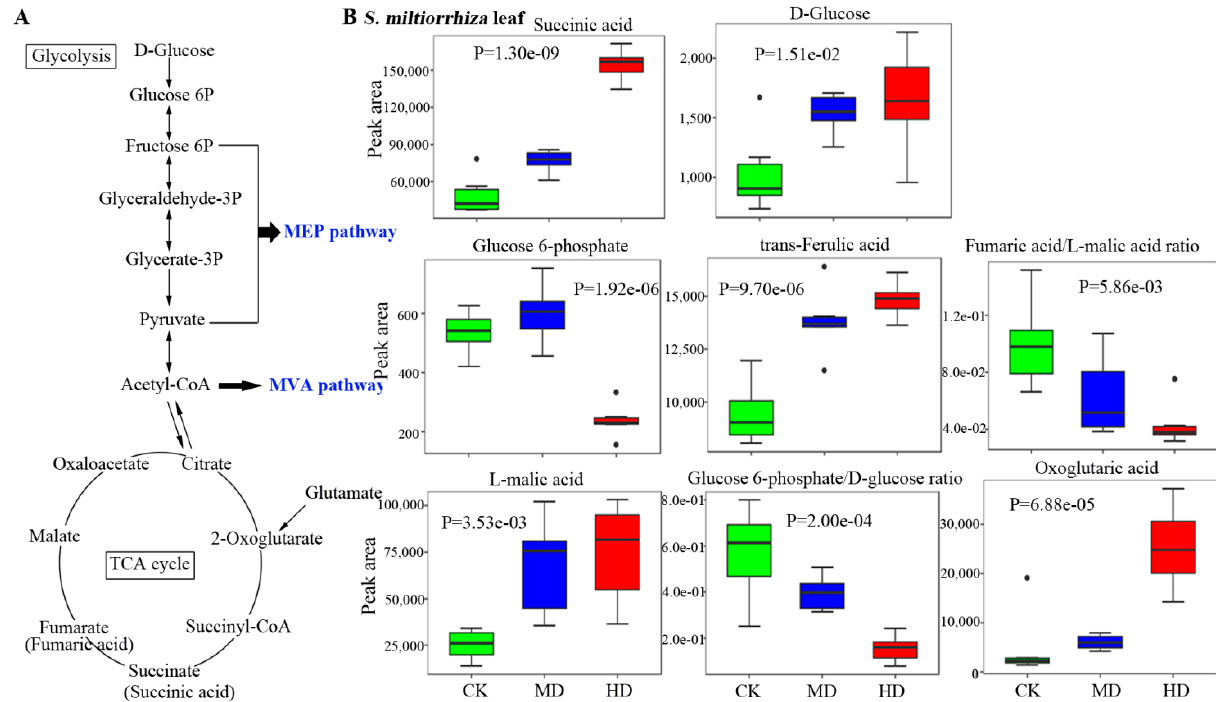
Figure 4. Metabolic profiles of terpenoid biosynthesis metabolites in Salvia miltiorrhiza Bunge. ( A ): the metabolic pathways (glycolysis and TCA cycle) producing primary substances of terpenoid biosynthesis. MVA, mevalonic acid. MEP, 2-methyl-D-erythritol 4-phosphate/methylerythritol phosphate. ( B ): the profiles of differential metabolites in S. miltiorrhiza leaf. CK, control. MD, moderate drought. HD, high (severe) drought. Univariate statistic method Kruskal–Wallis H test was used to analyze the different levels of metabolites. Data were expressed as median and range (interquartile range).